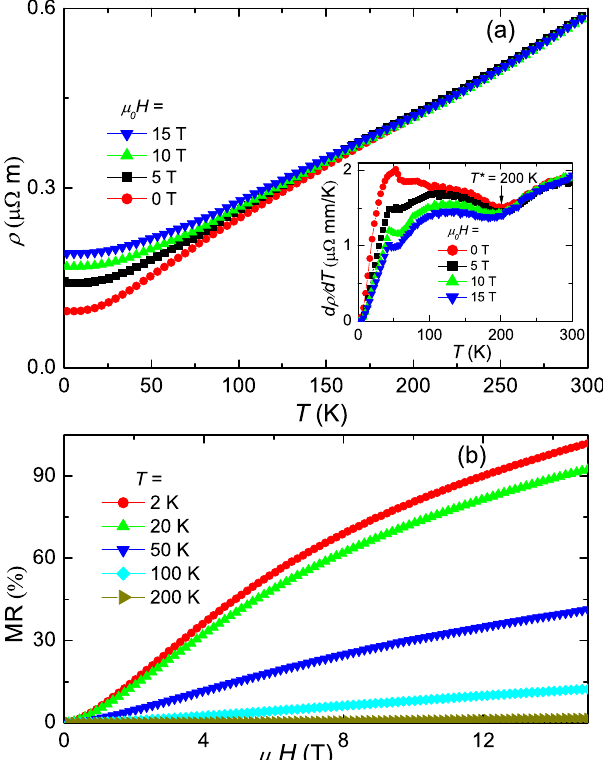
Figure 2. Transport properties of NbTe 4 at ambient pressure. ( a ) Plots of resistivity against temperature under = 0, 5, 10, and 15 T. The current is along the c -axis, and the field is along the b -axis. Inset: Plots of d ρ /d T μ 0 H versus temperature. ( b ) Field dependence of ρ ρ ρ = − H MR [ ( ) (0)]/ (0) under various